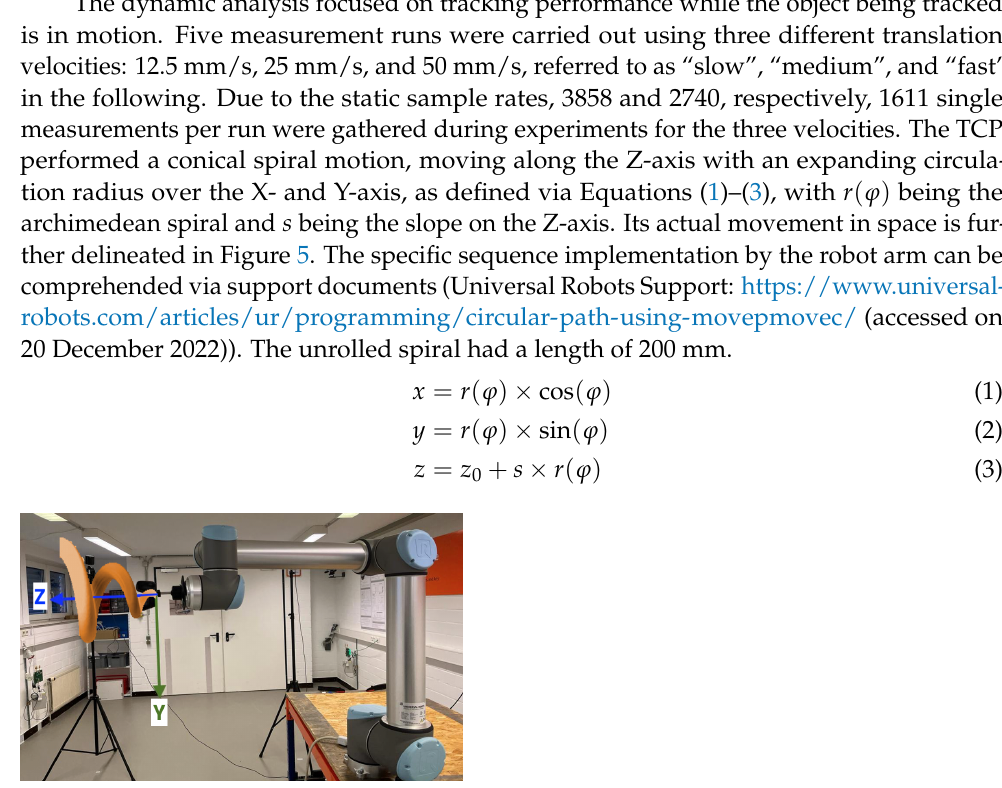
Figure 5. Side view of spiral trajectory around the Universal Robots UR10 robot arm TCP